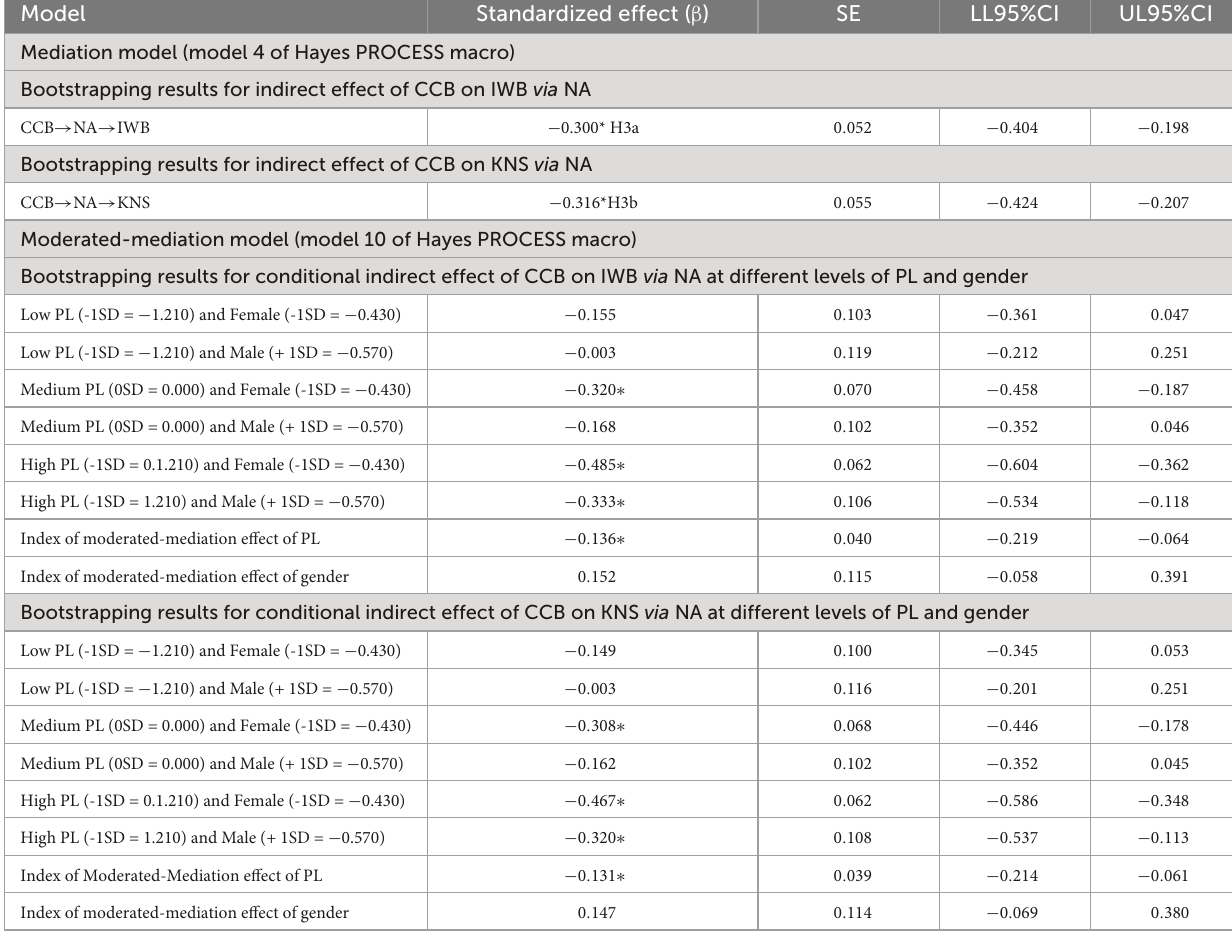
TABLE 4 Results of mediation and moderated-mediation analyses using PROCESS V3.5 by Andrew F. Hayes. Model Standardized effect ( β ) SE LL95%CI